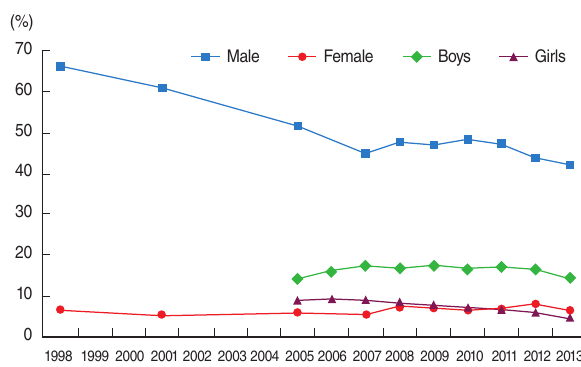
Figure 1. Trends in prevalence of current cigarette smoking 1,2 in the Korea National Health and Nutrition Examination Survey during 1998 to 2013, and Korea Youth Risk Behavior Web-based Survey during 2005 to 2013. Pro- portions of adults were calculated using the direct standardization method and was based on a 2005 population projection. 1 Adults (aged 19 years and older except for 1998 [20 years and older]; age-adjusted): percentage of adults who had smoked at least 5 packs of cigarettes (100 cigarettes) during their lifetime and who are currently smokers. 2 Adolescents (aged 13–18 years except for 2005 [13–17 years]): percentage of students who smoked more than 1 day during the past 30